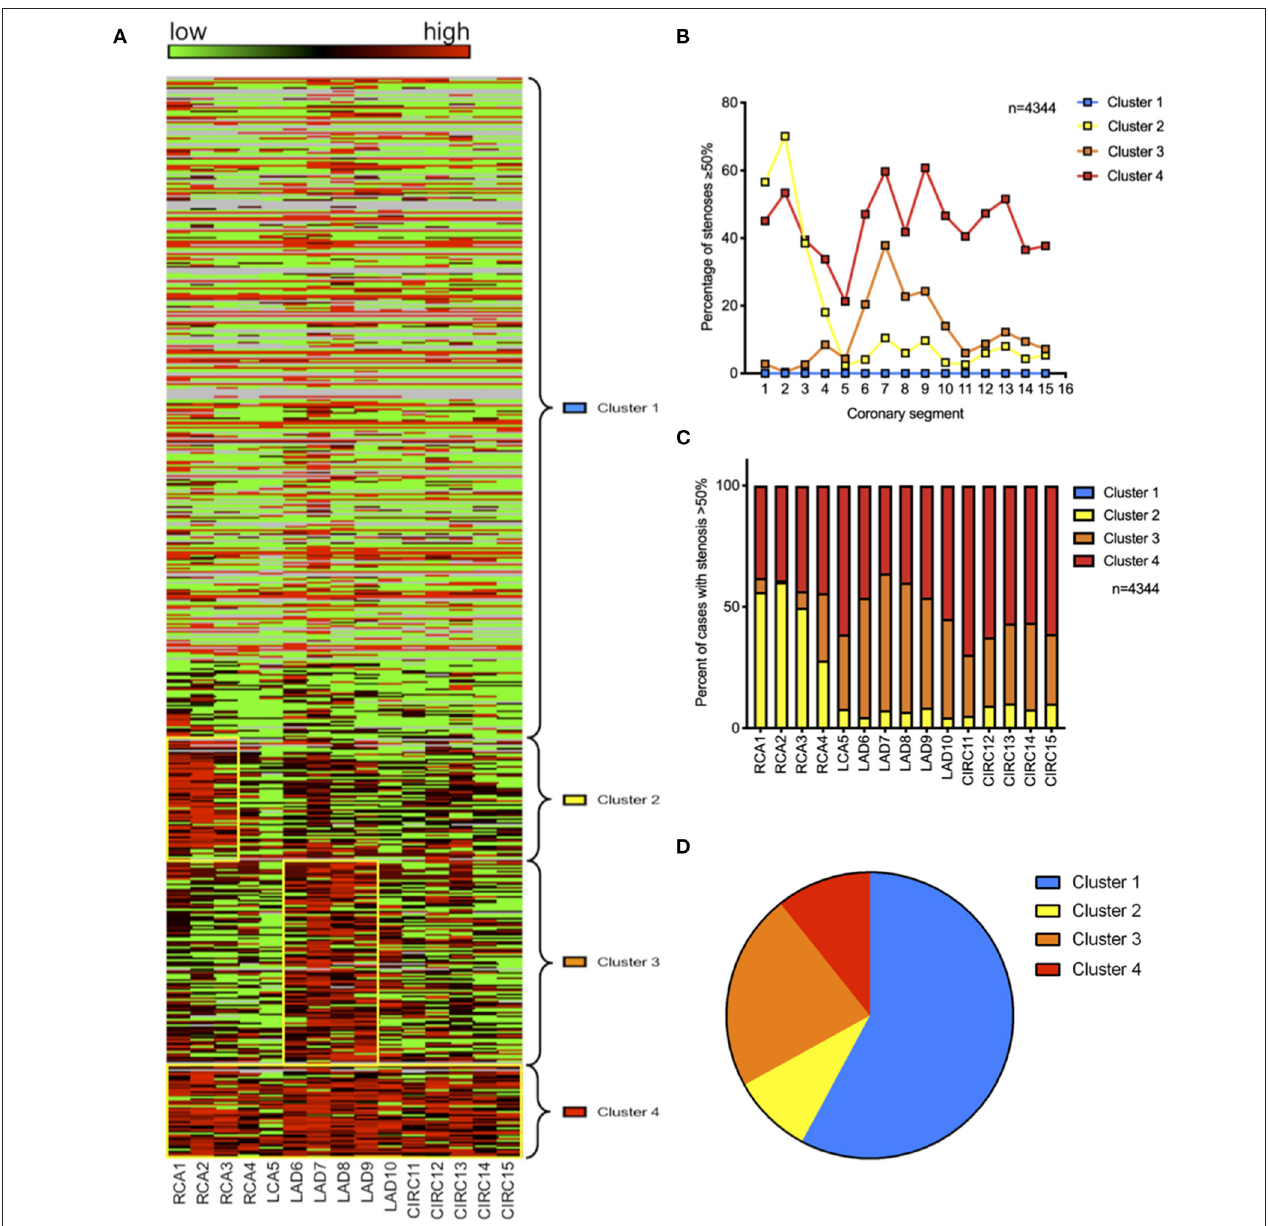
FIGURE 2 | Cluster analysis reveals four distinct phenotypes of coronary artery disease. (A) Heat map indicating the degree of stenosis by coronary segment (green = 0%, red = 100%) with free clustering of coronary segments to allow for best fit; yellow boxes indicate high grade stenoses in clusters 2, 3, and 4. (B) Average stenosis grade across the 15 Gensini segments within each cluster. (C) Percentage of stenoses > 50% per coronary segment and cluster of all stenoses > 50%. ( D) Prevalence of the four phenotypic clusters within the